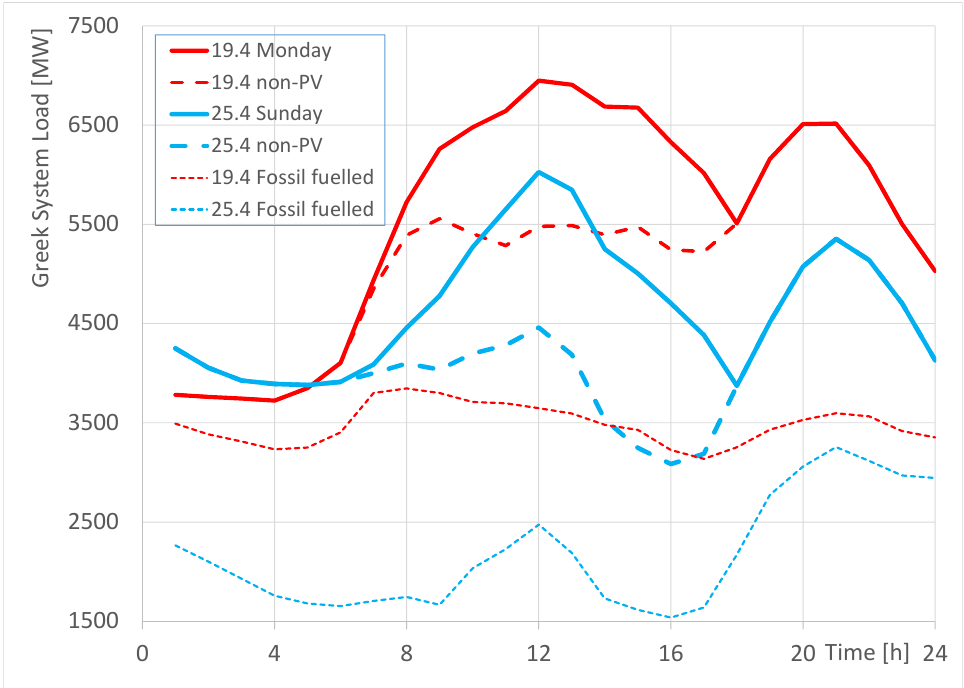
Figure 10. Greek system electricity load curve during a week-day and a weekend day (Sunday) with normal ambient temperatures and clear skies, in April 2021. For comparison, the load that is covered without the PV contribution, and the fossil-fuelled load are shown [42].